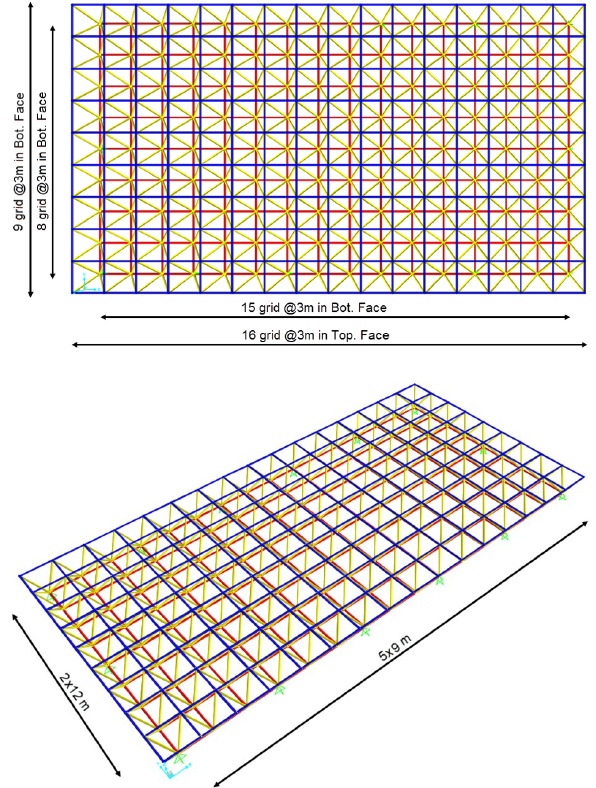
trussFigure 15. 1152-bar double-layer space